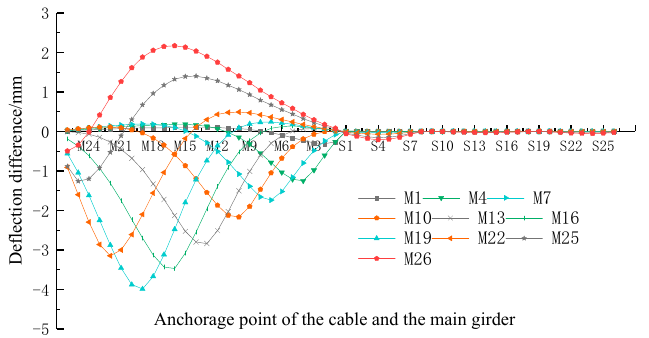
Figure 6. The distribution curves of the deflection difference of the girder before and after a cable damage (10%).